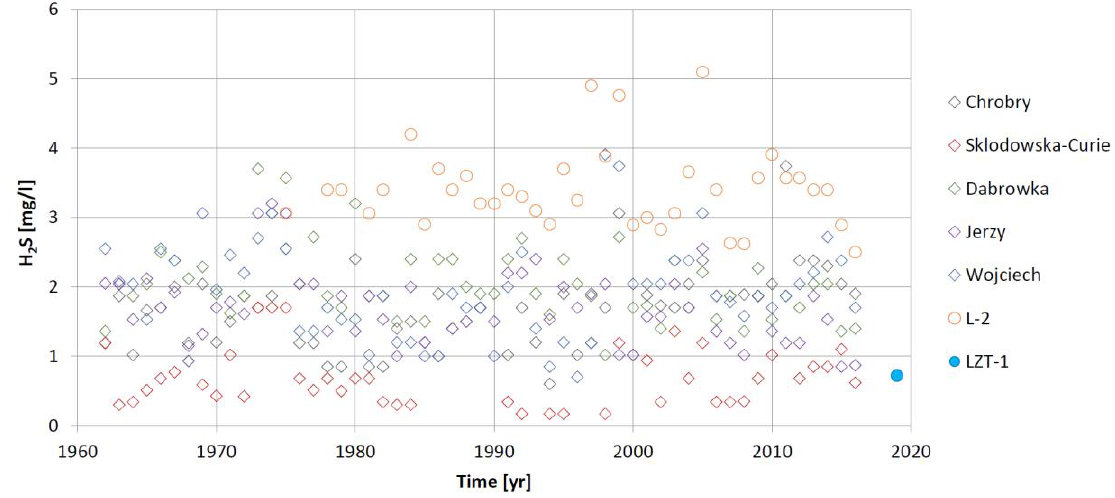
Figure 8. Variation in H 2 S concentrations dissolved in thermal waters (based on [44] updated).